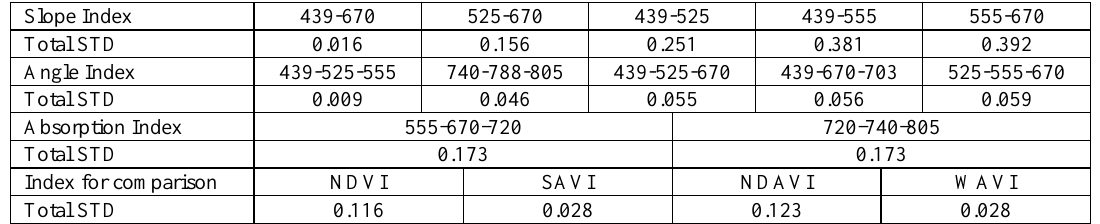
Table 3. The total standard deviations of different indices